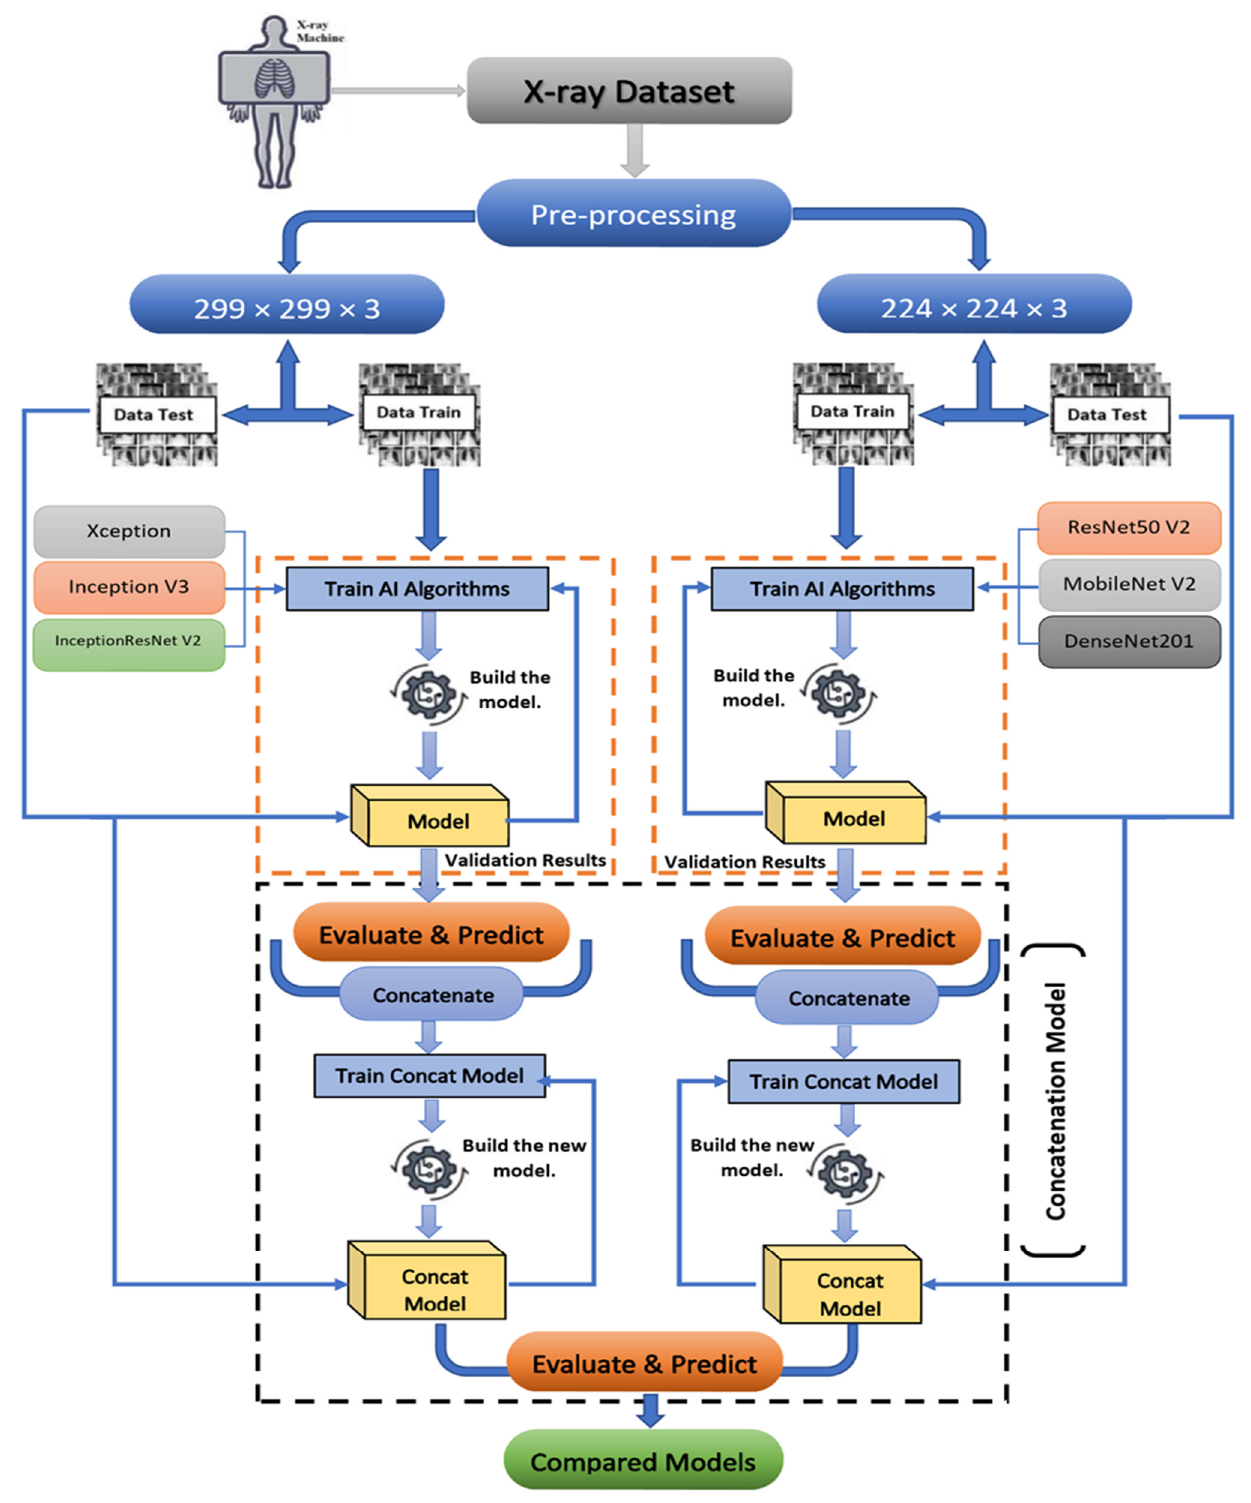
Figure 1. The proposed diagnosis system architecture.